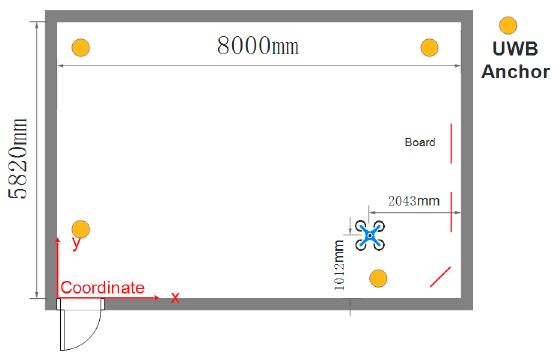
Table 3. Maximum errors of different methods.